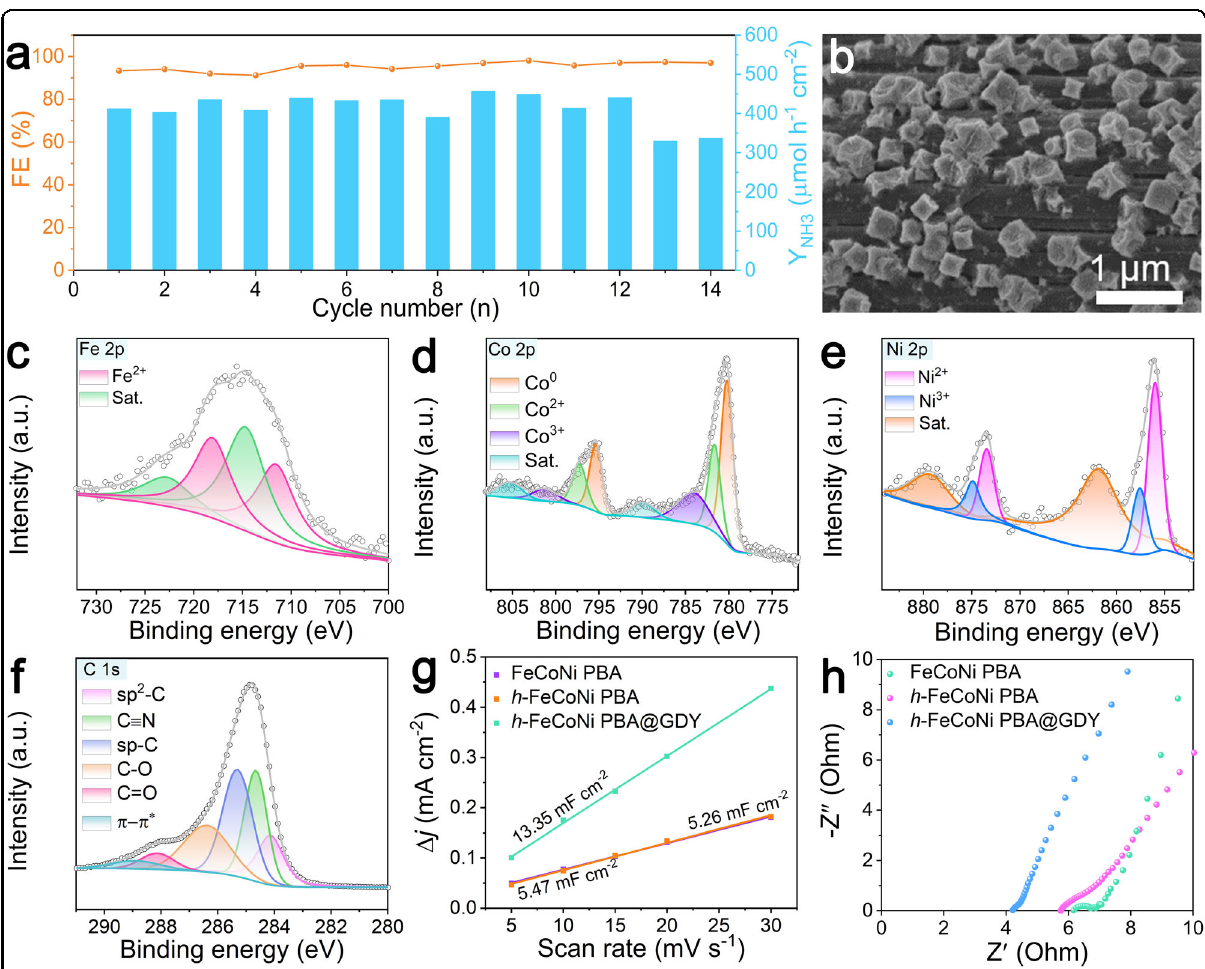
Fig. 6 Stability tests. a Stability test of the h -FeCoNi PBA@GDY catalyst at − 0.432 V versus RHE. b SEM image of h -FeCoNi PBA@GDY after the stability tests. c Fe 2p, d Co 2p, e Ni 2p, f C 1s XPS spectra of h -FeCoNi PBA@GDY after the ECNtRR. g Dependence of capacitive current on scan rate. h Nyquist plots of